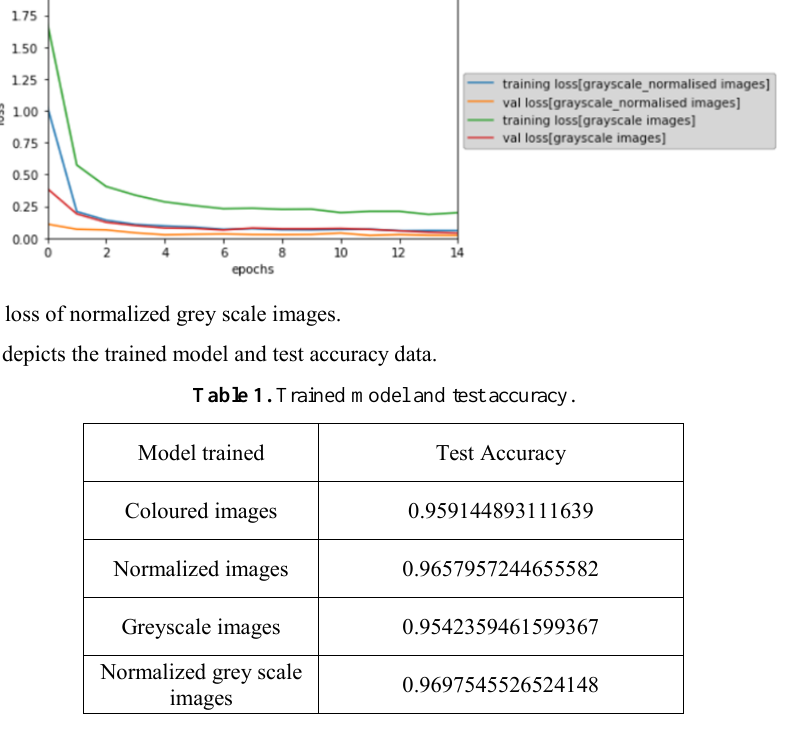
Table 2. Depicts the training validation accuracy and loss.